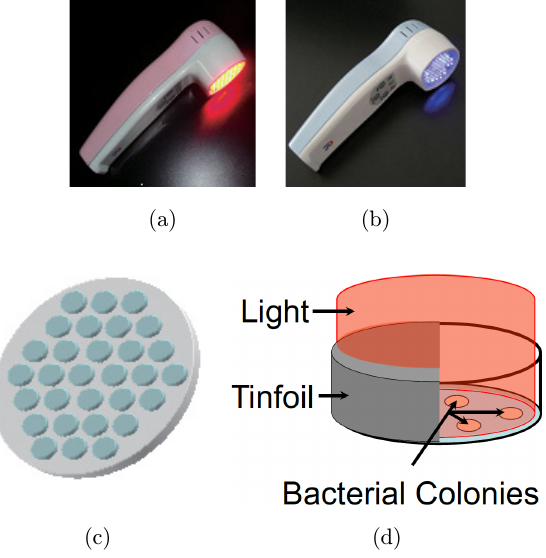
Fig. 1. Portable LED phototherapy device for in vitro peri- odontitis PDT: (a) Red LED phototherapy device; (b) Blue LED phototherapy device; (c) Schematic of LED array head; (d) Self-checking in in vitro periodontitis PDT: After tinfoil covering, only half of the plate was illuminated by LED pho- totherapy device. The covered half was considered as self-con- trol to reduce the deviation of plating